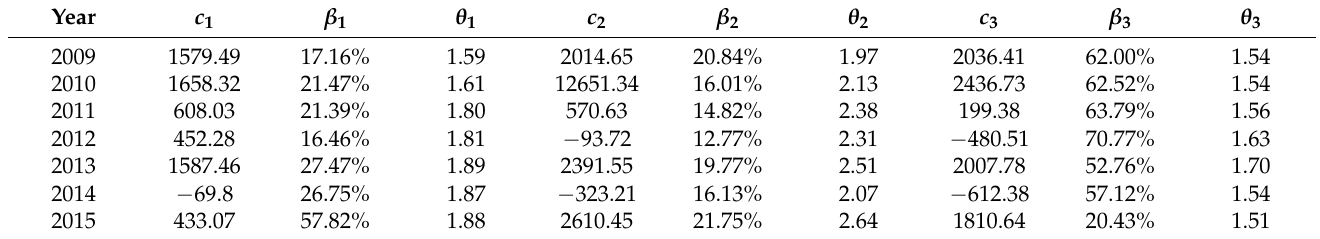
Figure 16. 3D waterfall diagram of average property value and occupancy ratio of the residential, commercial and industrial land: ( a ) Changes in average property value from 2009 to 2015 in Shanghai; ( b ) Changes in occupancy ratio from 2009 to 2015 in Shanghai. Table 2. Average property and occupancy ratio of the residential, commercial and industrial